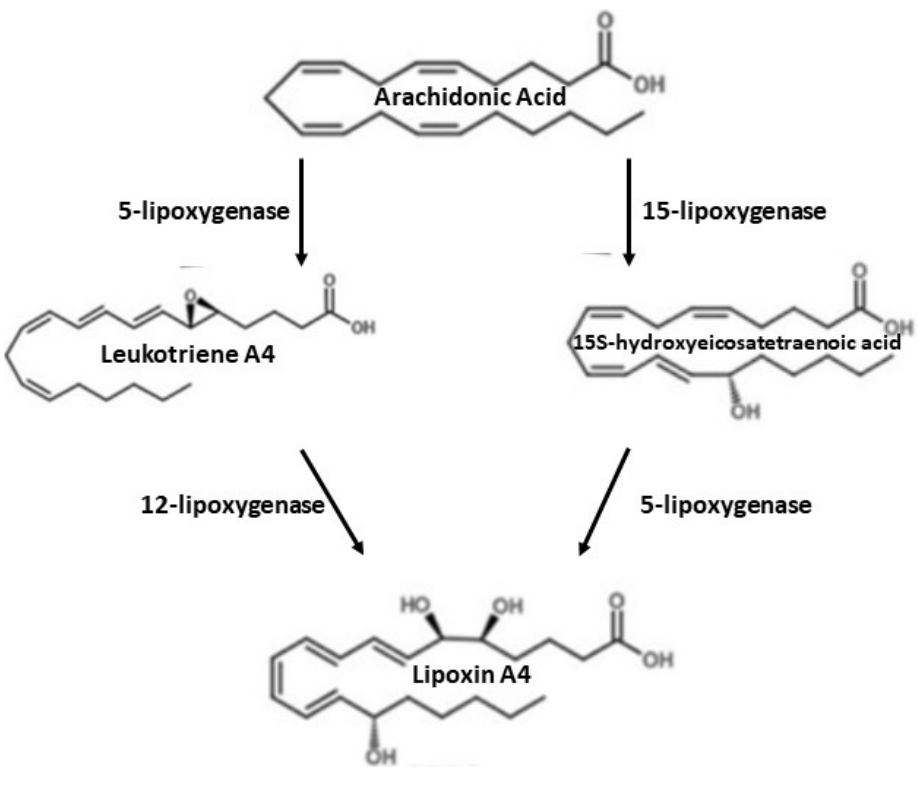
Figure 1. Synthesis of lipoxin A4.